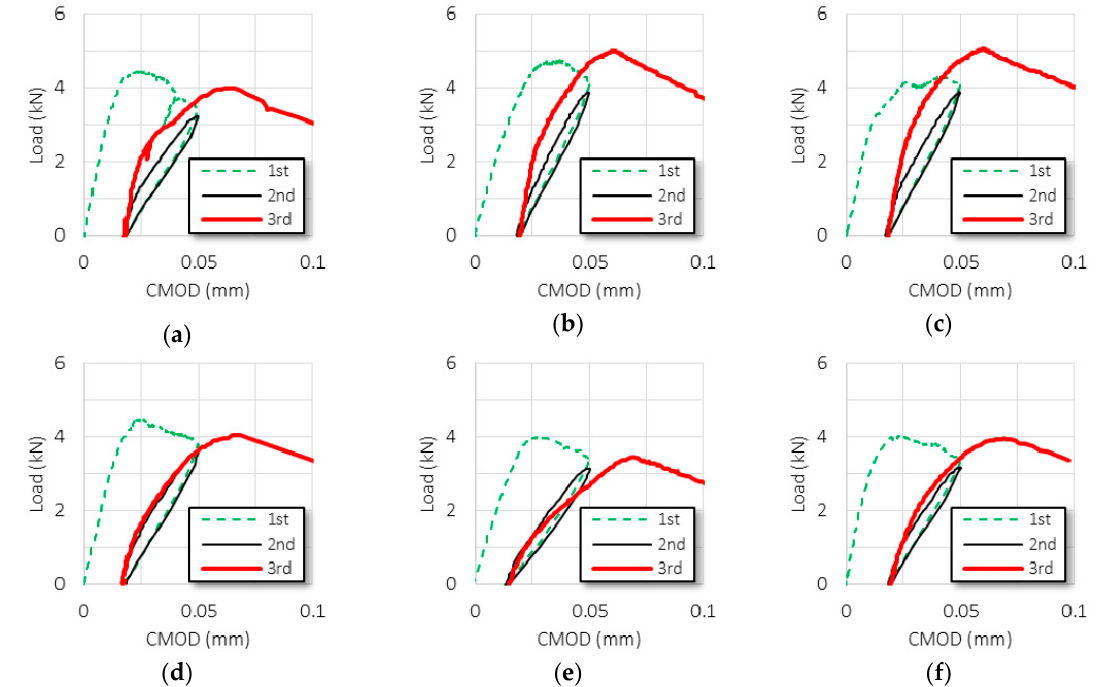
Figure 7. Typical load-CMOD curves for different healing periods: ( a ) 7-28W; ( b ) 7-49W; ( c ) 7-70W; ( d ) 7-28A; ( e ) 7-49A; ( f ) 7-70A.